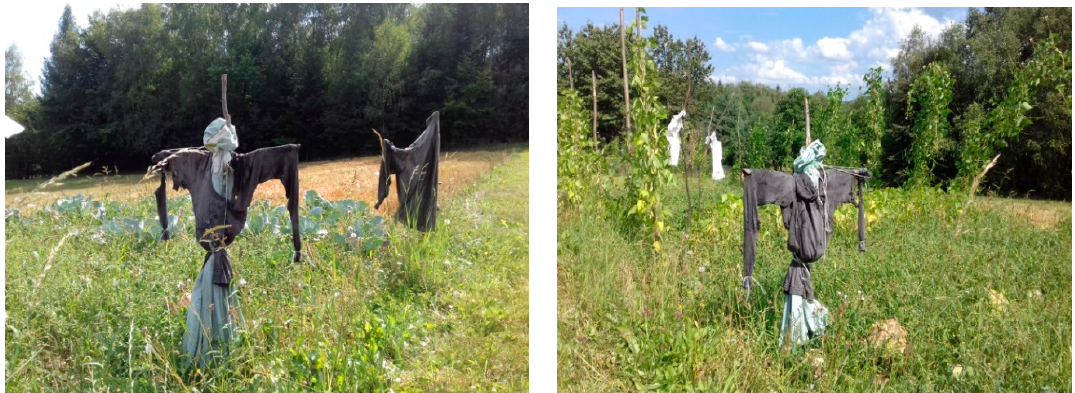
Figure 5. Scarecrows in a vegetable patch. Suburban farming. Near Stary S ą cz (Ma ł opolskie Voivodeship). Source: author.